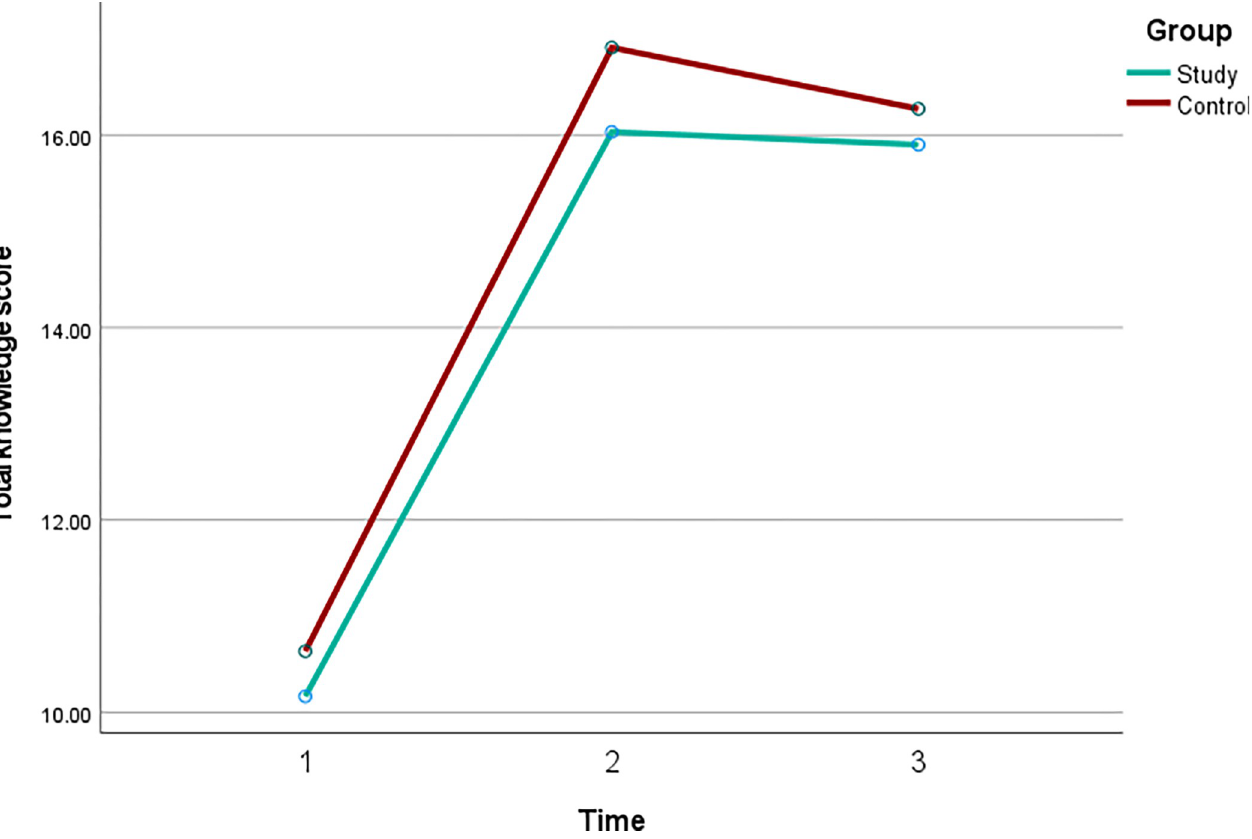
Fig 2. Changes in total knowledge scores over